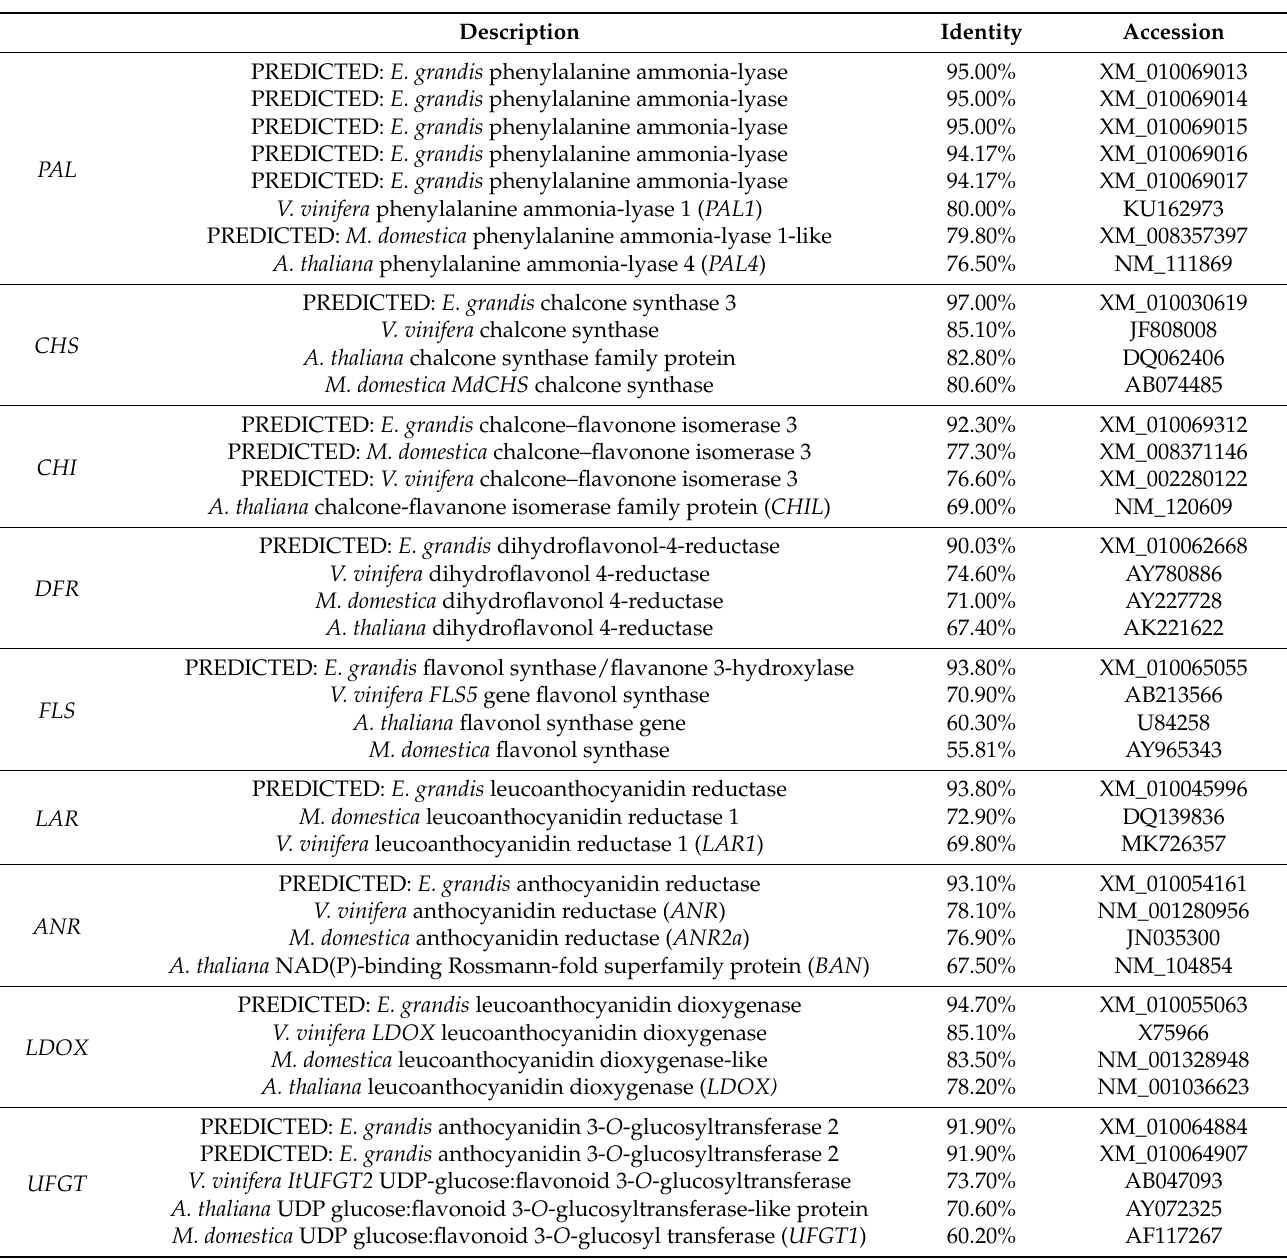
Table 1. Percentage of identity for partial sequences from myrtle with other species.